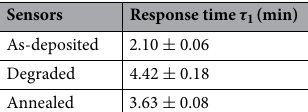
Table 1. Response time of the sensor to 1000 ppm of hydrogen in